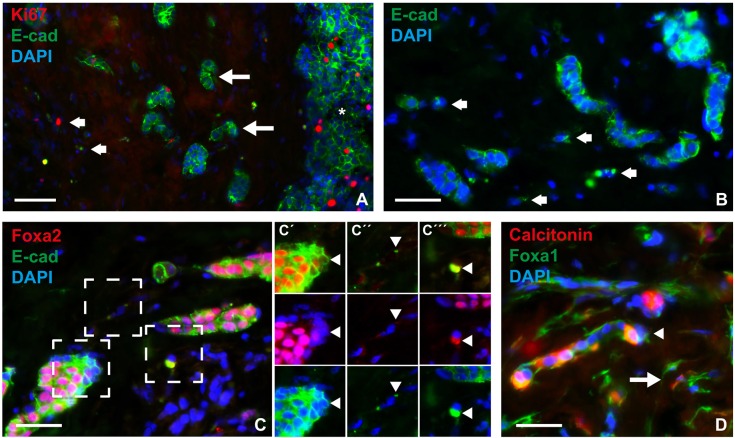
Altered Foxa2 expression in invasive MTC tumor cells. Sections were co-stained for E-cadherin (E-cad) to evaluate concurrent epithelial-to-mesenchymal transition. (A) Overview of tumor invasive zone. Large arrows indicate clusters of infiltrating tumor cells close to a large tumor nodule (asterisk); small arrows indicate distanced single tumor cells. Note that Ki67+ cells are not enriched in the tumor stroma compared with solid tumor nodule. (B) Redistribution of E-cadherin from the surface of single tumor cells (arrows). (C) Coordinated loss of Foxa2 in invasive tumor cells. Three areas (dashed boxes) of motif are shown in C′-C‴ with alternating channels for improved resolution: Foxa2 and E-cad (upper panel); Foxa2 and DAPI (middle panel); and E-cad and DAPI (lower panel). Arrowheads indicate different cell phenotypes further commented on in the Results. (D) Preserved expression of Foxa1 confined to the cytoplasm in infiltrating tumor cells. Note variable expression of calcitonin in both single tumor cells (arrow) and small aggregates (arrowhead). Scale bars: 50 µm (A); 25 µm (B-D).